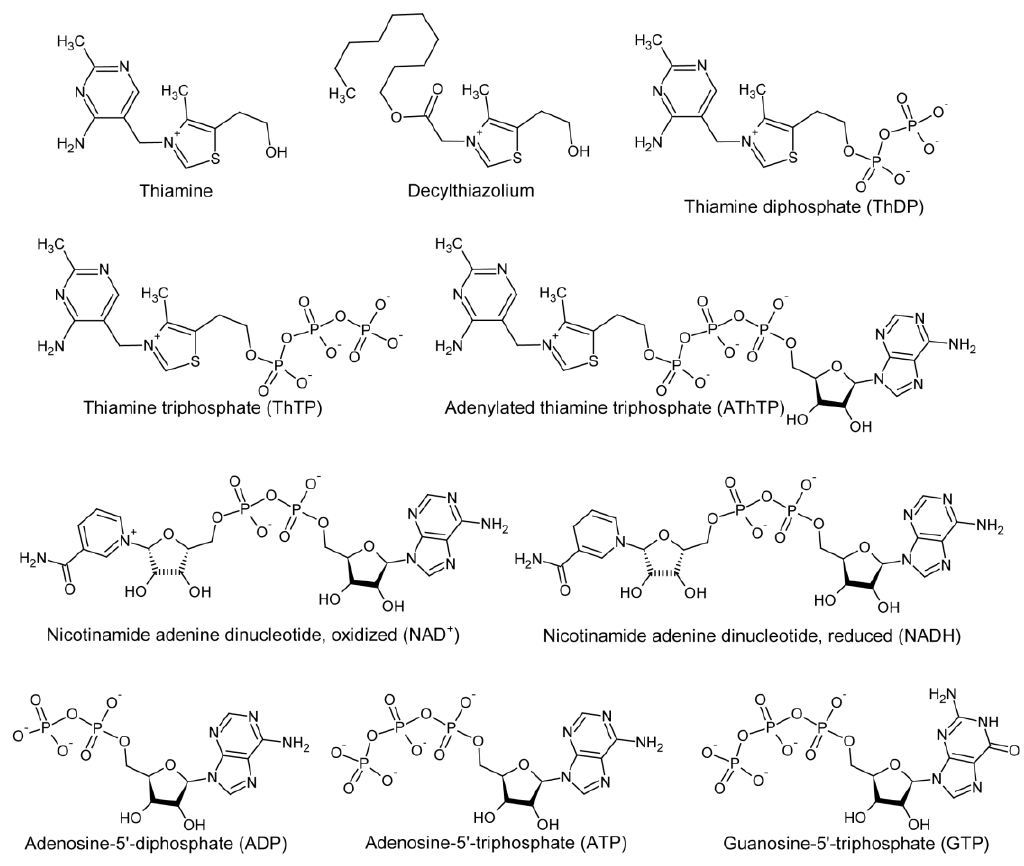
Figure 4. Structures of thiamine, its structural analog (decylthiazolium), natural derivatives of thiamine (ThDP, ThTP and AThTP), and the related nucleotides (NAD + , NADH, ADP, ATP and